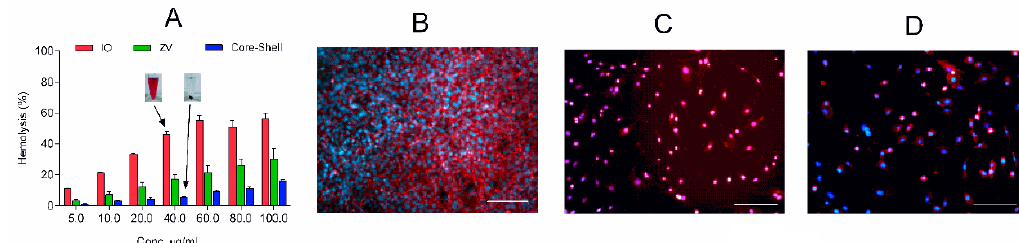
Figure 7. E ff ect of the surface modification on the hemolysis of the particles at di ff erent concentrations. ( A ) Micrographs of NIH / 3T3 cells incubated with core–shell microparticles after exposure to US treatment. Values are reported as averages, and error bars represent the SD (n = 3). The micrographs were taken after 24 h of exposure; 50 µ g / mL was the microparticle concentration used. ( B ) Control, only cells. ( C ) Cells incubated with core–shell microparticles and exposed to US treatment at 2 W / cm 2 . ( D ) Cells incubated with core–shell microparticles and exposed to US treatment at 20 W / cm 2 .